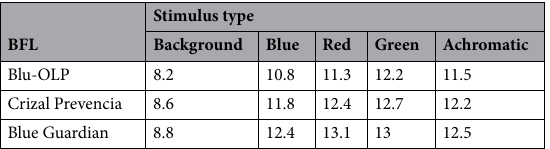
Table 1. Luminance measurements (in cd/m 2 ) of the background and stimuli when taken through the three BFL